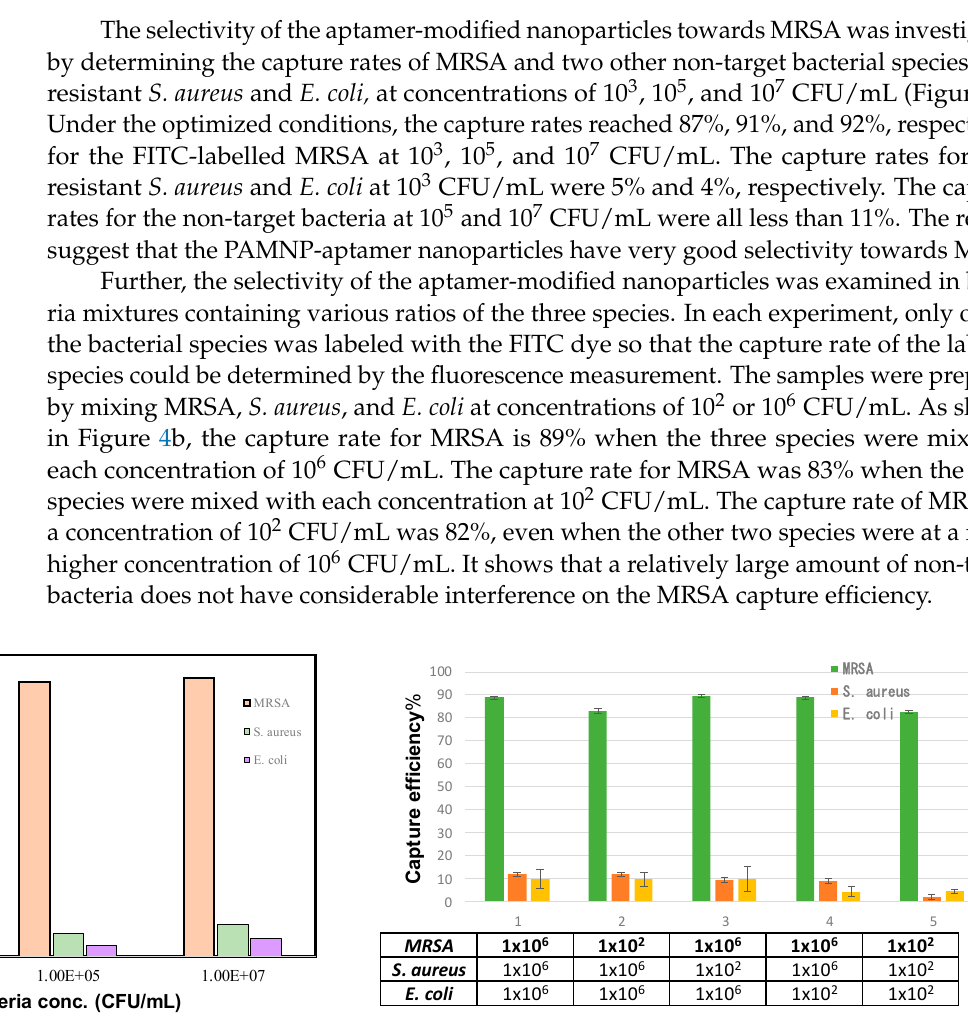
Figure 3. Optimization of reaction conditions for the capture experiments using PAMNP-aptamer: ( a ) capture efficiency (at 25 °C or 37 °C) of MRSA bacteria (10 7 CFU/mL) with and without preheating (100 °C, 5 min) of PAMNP-aptamer; ( b ) capture of MRSA bacteria at different reaction times from 0 to 2 h with varying amount of PAMNP-aptamer (1–5 mg).